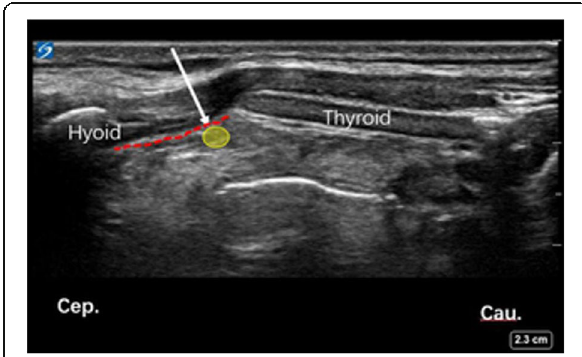
Fig. 1 The hyoid bone and thyroid cartilage were marked in the ultrasound image. The red dotted line and yellow circle represented the thyrohyoid membrane and superior laryngeal nerve place, respectively. The white arrow represented the needle